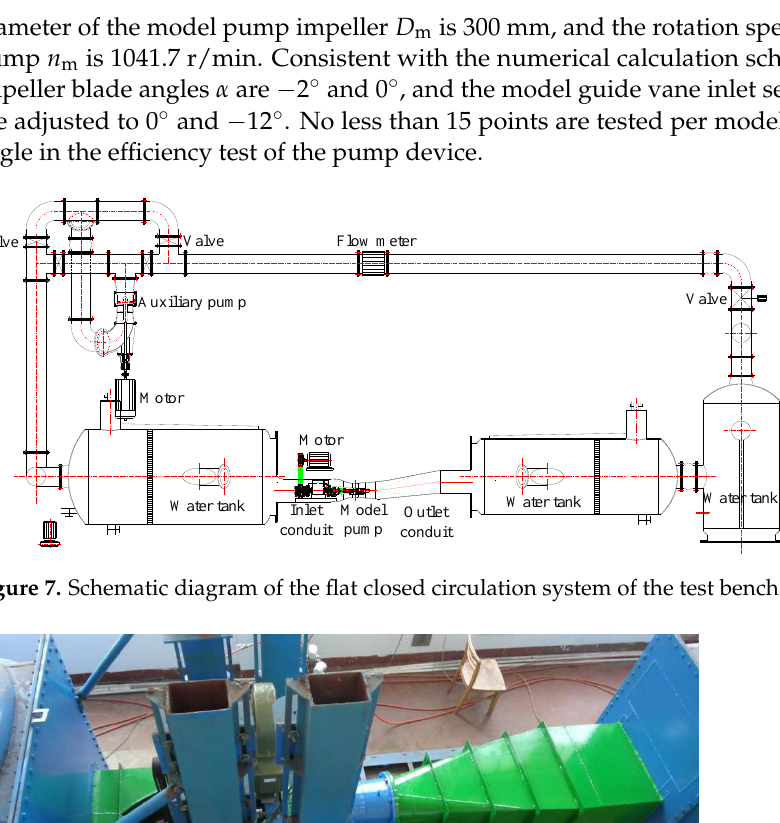
Figure 8. Photo of the model shaft tubular pump device.